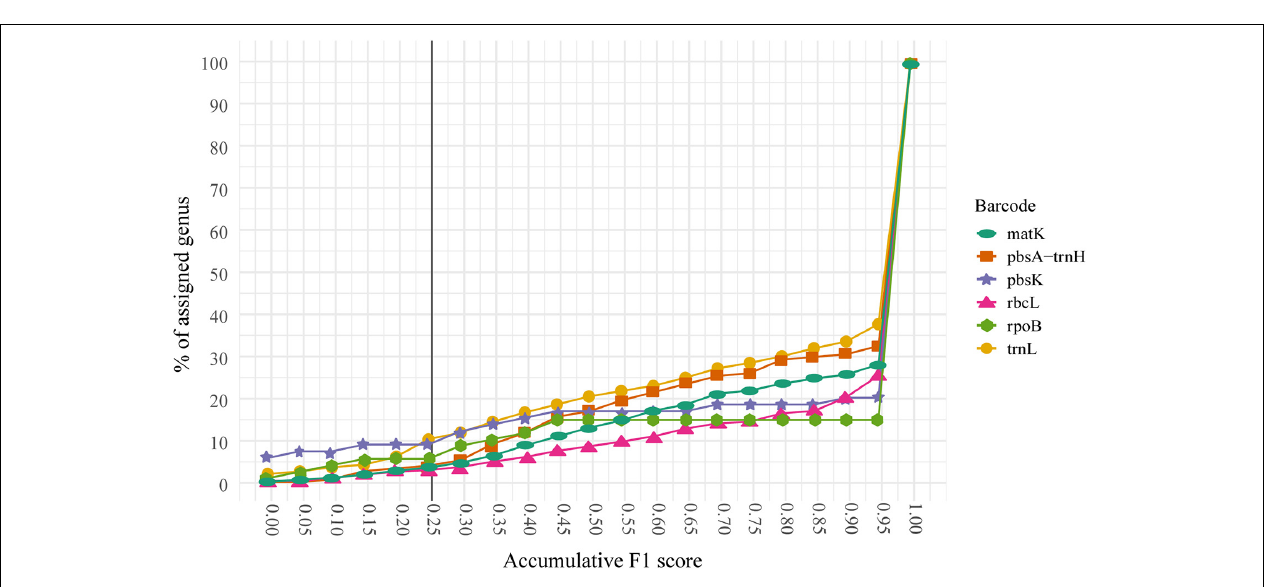
FIGURE 4 | Cumulative F1 score for the 5–20 dataset for every marker. The cumulative percentage of assigned genus at every F1 score threshold is shown. Thus, 100% of the genera are assigned at a cut-off of 1.0 or below. Notice that less than 10% of the genera had an F1 score of 0.25 or below and 65% of the genera shows a score of 0.9 or above for every marker. The shown line defines the threshold for the genera that will be handpicked to evaluate their possible causes of